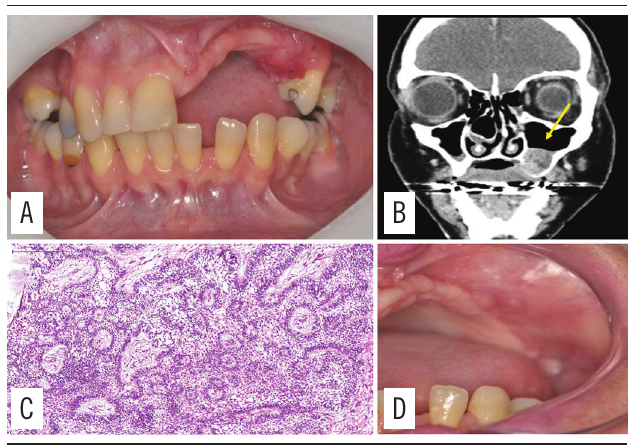
figura 2 − A) visão clínica pré-operatória da primeira recorrência da lesão; B) TC que mostra uma imagem hipodensa com ruptura da cortical óssea e invasão do seio maxilar (seta amarela); C) ilhas de células hipercromáticas com paliçadas periféricas e zonas centrais parecem retículo estrelado (HE, 200 µm); D) aspecto clínico pós-operatório TC: tomografia computadorizada; HE: hematoxilina e eosina.